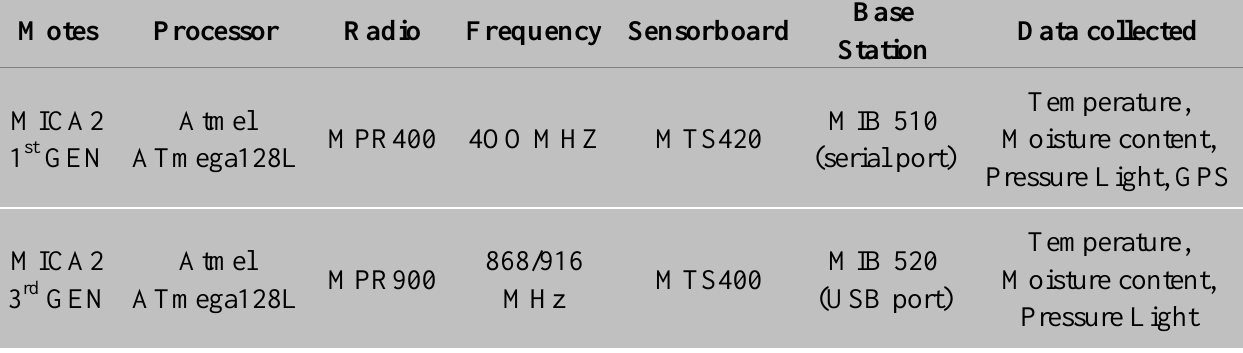
Table 1. Characteristics of motes and the equipments.